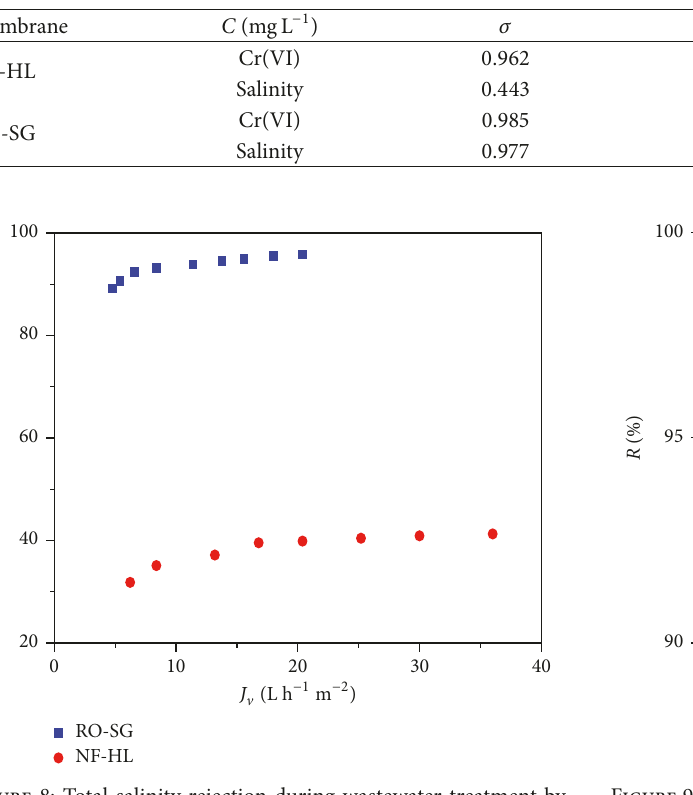
Table 5: Reflection coefficients ( 𝜎 ) and solute permeabilities ( 𝑃 𝑠 ) for total salinity and Cr(VI) ions of treated wastewater by NF-HL and RO-SG membranes.